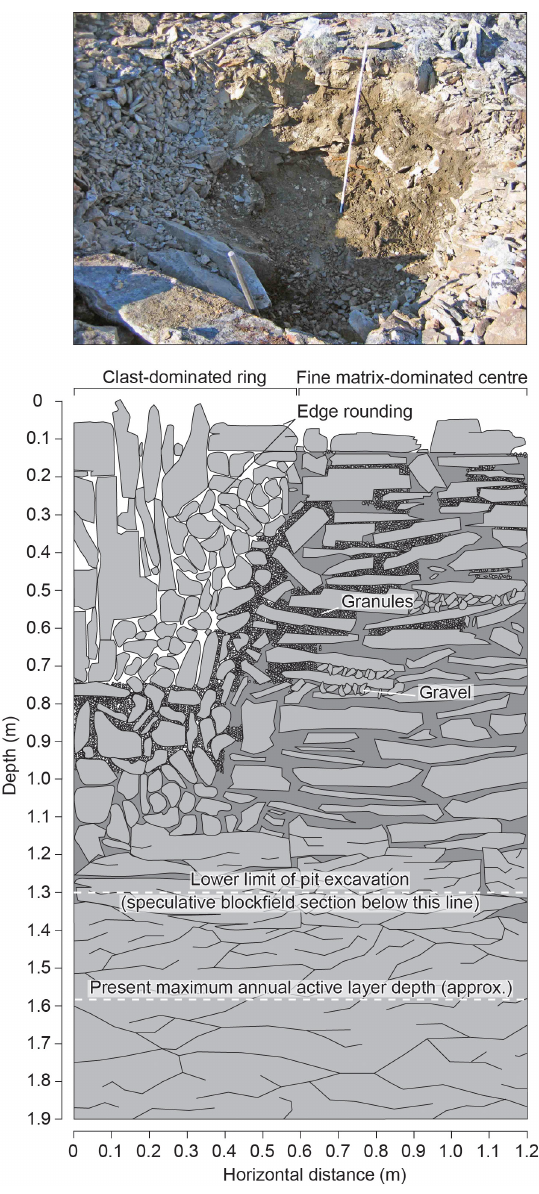
Figure 3. Representative vertical sections of autochthonous block- fields. The photograph shows an excavation across one of the sparsely distributed sorted circles developed in the summit block- field of Tarfalatjårro, and the line drawing summarizes the general features of autochthonous blockfields in a vertical section cut across a periglacially sorted circle. The ruler in the photograph is 1m in length. Angular cobbles and boulders are embedded in fine matrix (clay, silt, sand) in sorted circle centres. Granules and gravel accu- mulate between clasts distributed vertically through the section that have subhorizontally oriented long axes. Conversely, the outer ring of the sorted circle is comprised of gravel, cobbles, and boulders, whereas granules accumulate near the base of the section. Clast sur- faces are sub-rounded where they are subaerially exposed. The pit bases generally intersect large rock slabs and are wet.